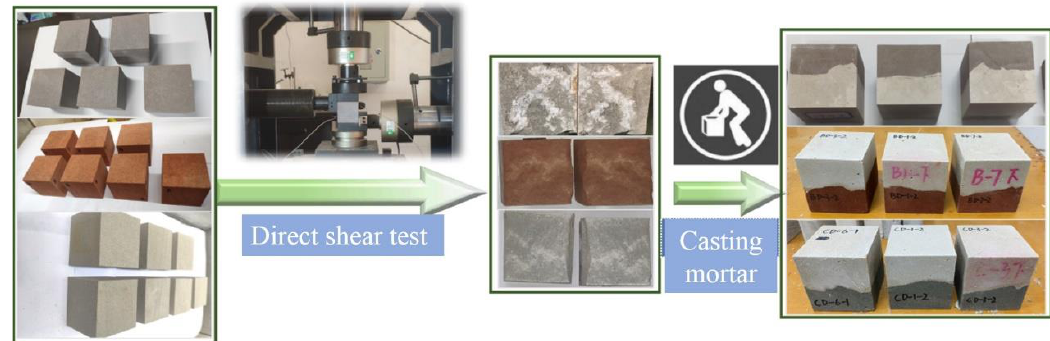
Figure 6. Rock – mortar interface preparation flow.